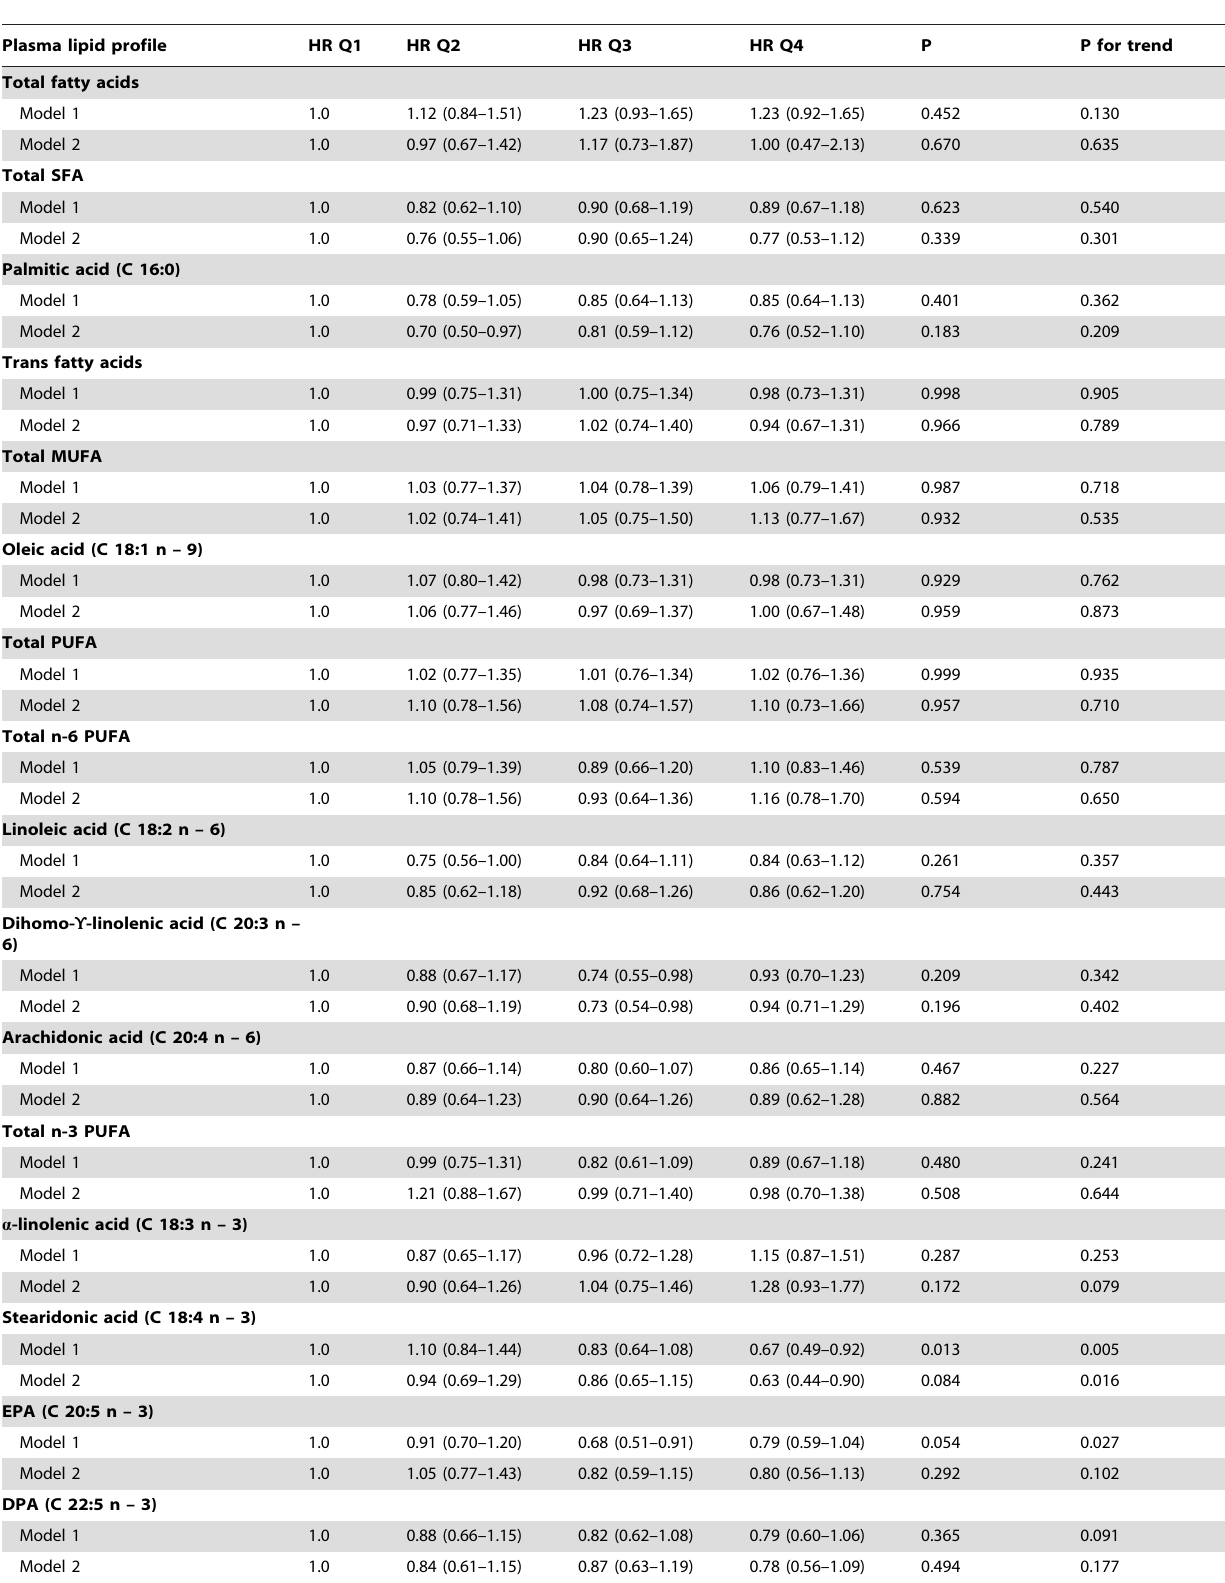
Table 4. Multivariate hazard ratios (95% confidence intervals) showing the associations between baseline plasma lipid profile and incident cardiac events in the SU.FOL.OM3